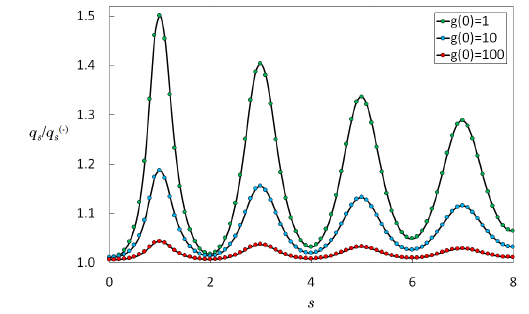
Figure 9. Dependence of the ratios q s / q For both plots g ( 0 ) = 100.